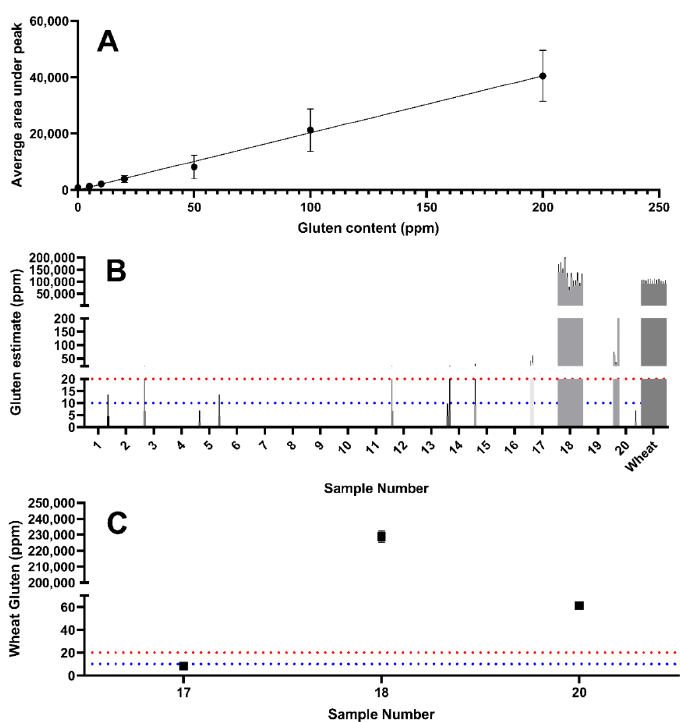
Figure 4. Estimates of the concentration of gluten in the samples were made by comparing to wheat samples diluted in a solution of gluten-free yeast extract. Samples were weighed independently in quadruplicate and peptide peak area measured and plotted as a calibration curve ( A ). This data was then used to generate estimates of gluten concentration across all tested samples ( B ) with clear detection in samples 17, 18, and 20 for 12 peptides ( n = 4 replicates). Wheat gluten estimate based on the sample mean of all wheat gluten peptides and interpolated from the calibration curve ( C ). The dashed red line represents the 20 mg / kg threshold, whilst the dashed blue line represents the 10 mg / kg GFCO certification